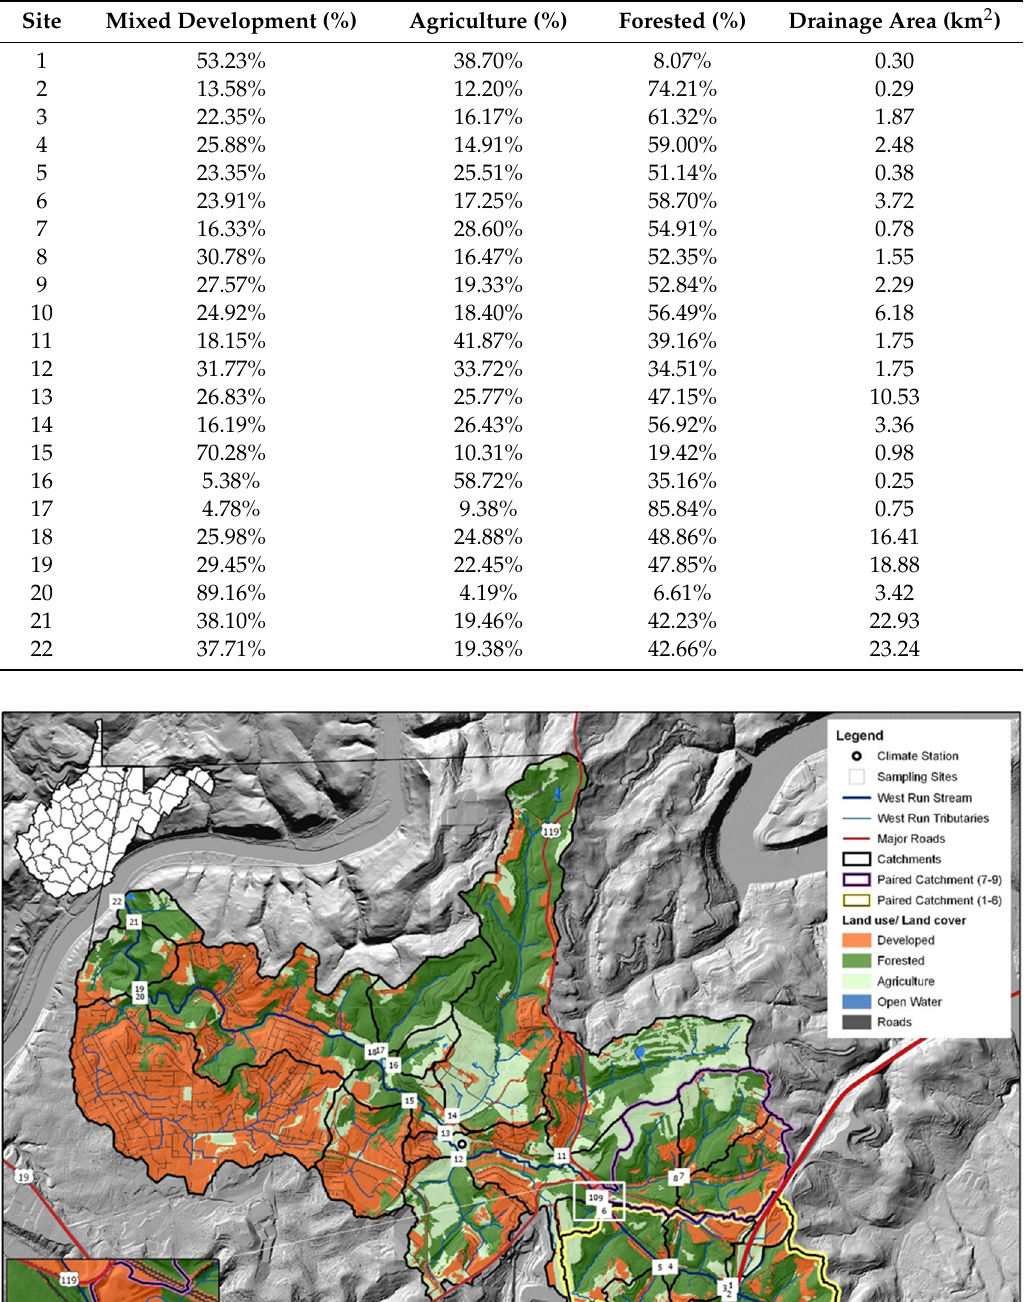
Table 1. Land use / land cover characteristics (% cover) and total drainage area (km 2 ) at 22 monitoring sites in West Run Watershed (WRW), West Virginia, USA. Note: land use percentages may not sum to 100%, as not every category is included (i.e., wetland, open water, etc.) and some categories are combinations of others (e.g., mixed development = urban + residential). Final row (Site #22) indicates the total values for the entire watershed.